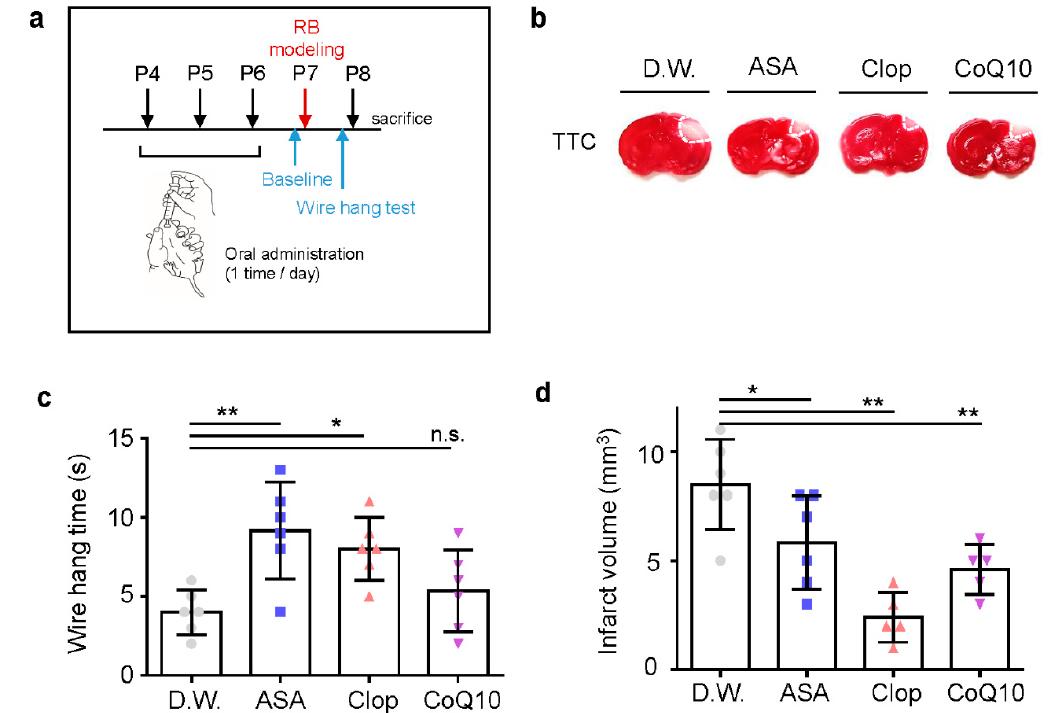
Figure 3. Neuroprotective effects of drug pre-treatment on infarct volume and behavioral function in a neonatal rat model of photothrombotic stroke. ( a ) Experimental design for drug treatment by oral administration and RB animal modeling. ( b ) Representative images of coronal brain sections stained with TTC. ( c ) Grip test for time assay, as assessed 24 h after RB modeling. ( d ) Brain infarct volumes in rats after 24 h are presented as mean ± SD. ** p < 0.005; * p < 0.01 compared with the D.W. group.